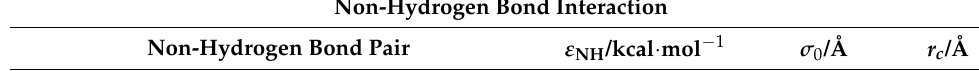
Table 2. Potential parameters of the non-hydrogen bond interaction. The strength of interaction between phospholipid or protein and cis-1,4-polyisoprene repeating unit (set to be identical) is a variable in our